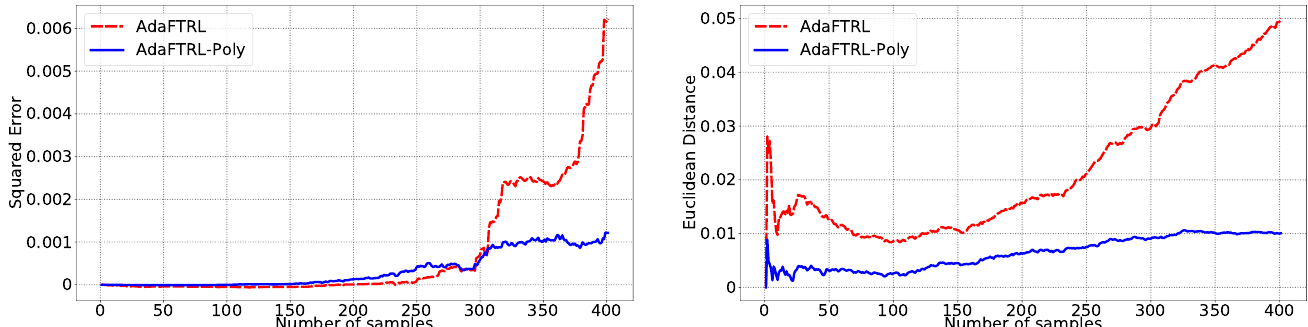
Figure A5. Relative performance for Google Flu.